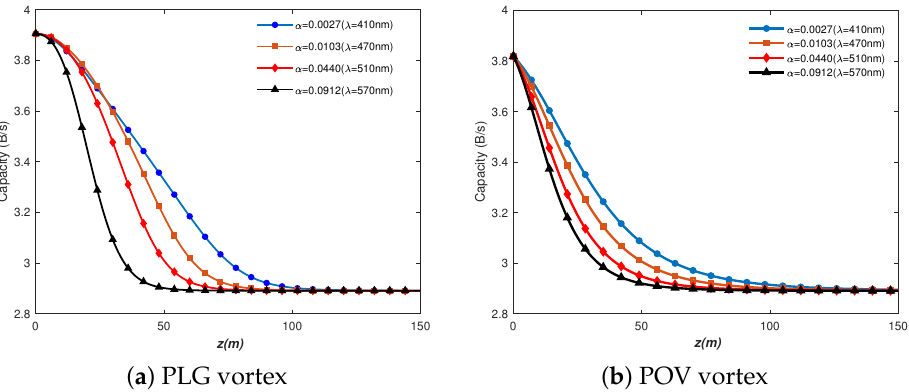
Figure 3. Information capacity of OAM channels with the carriers of PLG vortex and POV vortex versus signal wavelength and propagation distance. Table 2. Performance comparison between PLG system and POV